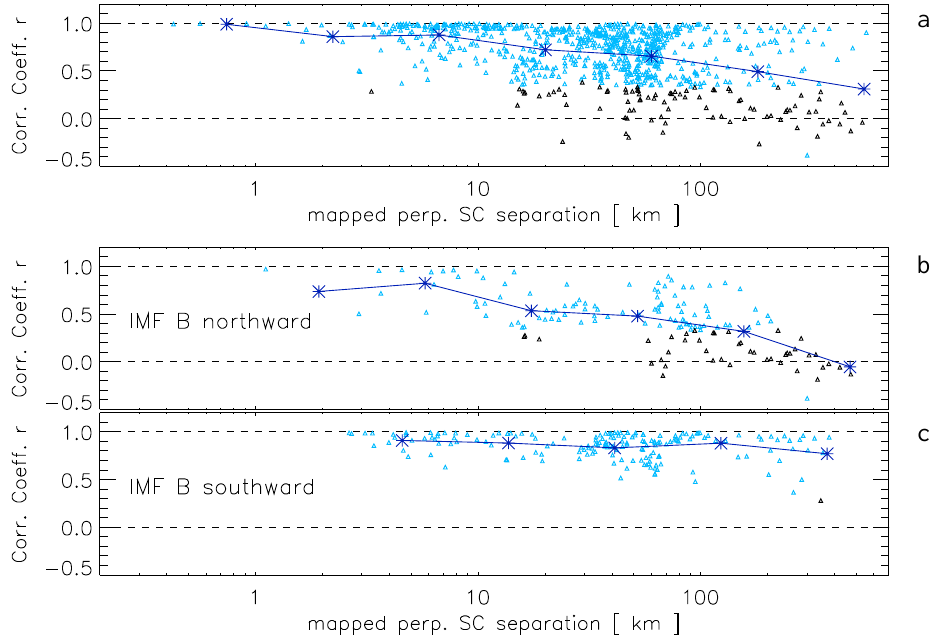
Fig. 9. (a) Correlation coefficients of 1-h intervals of 60-s smoothed ˜ V s vs. mapped spacecraft separation distances transverse to the magnetic field; correlation coefficients above the significance threshold are colored blue, the others black; (b) and (c) same as (a), except the subset of cases with steady IMF have been separated into IMF northward and southward, respectively. The asterisks interconnected by straight lines show the average